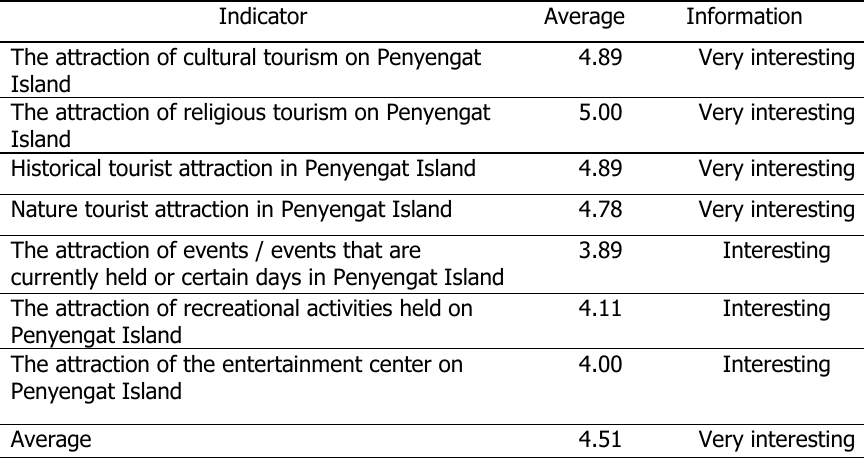
Table 4. Attraction attribute assessment